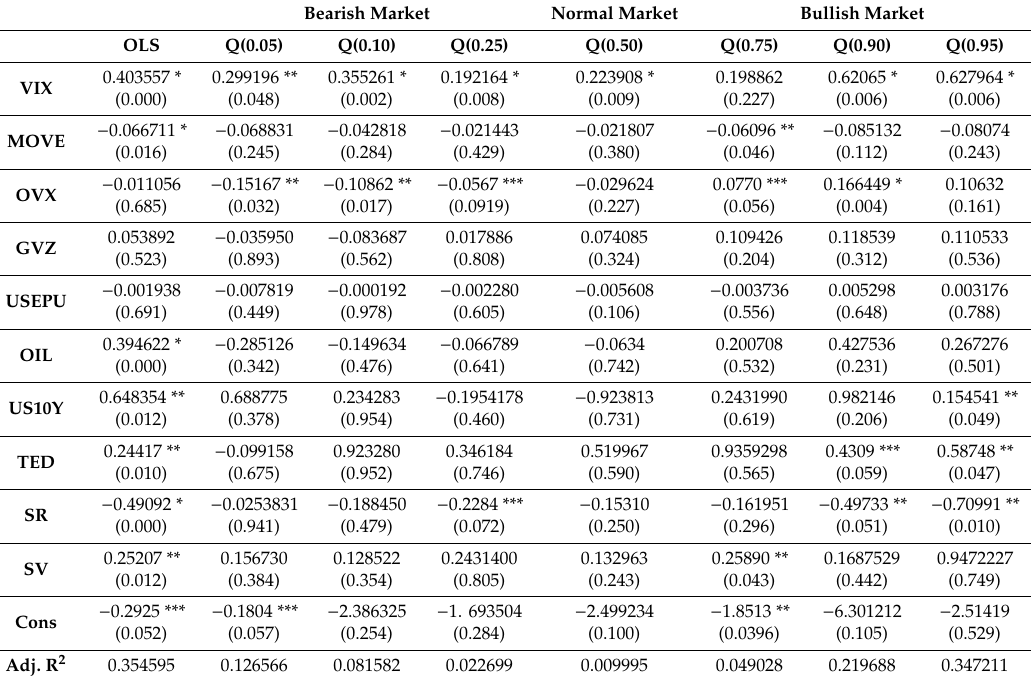
Note: This table presents the quantile regression parameter estimates for the model described in Equation (2). The numbers in parentheses are the p -values. The asterisk (*, **, ***) denotes statistical significance at the 1%, 5%, and 10% levels, respectively. Number of observations: 1465.